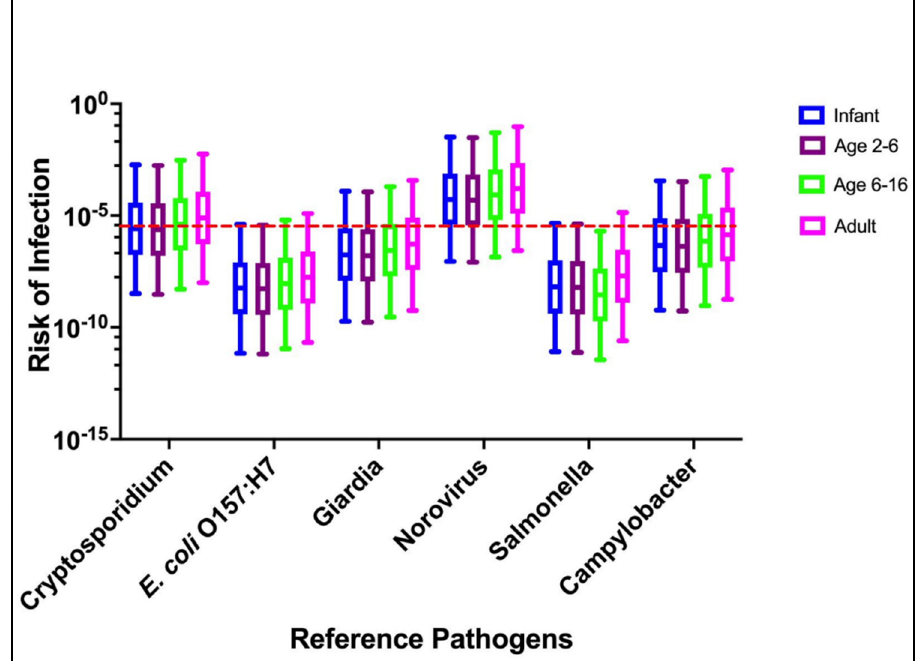
Figure 3. Daily risk of a GI infection following ingestion of contaminated drinking water. The red dashed line represents the modified U.S. EPA daily risk threshold (1 × 10 − 6 ).